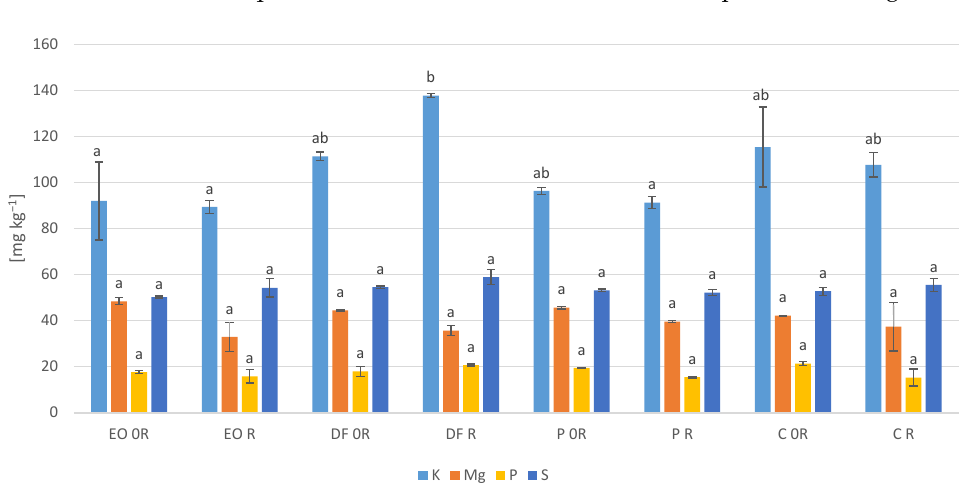
Figure 3. The effect of PDSs and bioremediation on the content of heavy metals in the experimental soils (acid-extracted elements). The means (±SE) for individual elements that are marked with the same letters did not differ significantly according to Tukey’s test at p < 0.05. The symbols are the same as those in Table 3. The analysis of the potentially bioavailable heavy metals in the experimental soils showed that the content of copper and, in most cases, nickel, lead and cadmium were below the method’s quantification limit (Figure 4). Therefore, the content of copper is not presented in Figure 4. The content of manganese and zinc in the EO-contaminated soil was significantly higher than in the control soil. A higher content of manganese was recorded in the soil that had been contaminated with P, while a slightly higher content of cadmium was recorded in the soil that had been contaminated with DF. The addition of